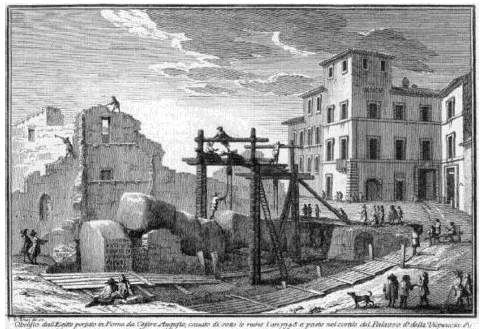
Figure 7: Giuseppe Vasi, Obelisco dall'Egitto portato in Roma